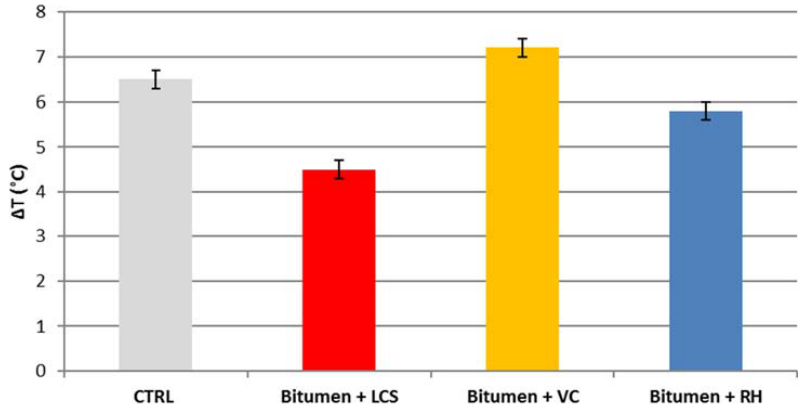
Figure 4. Comparison of Δ T = T TR (aged) − T TR (unaged) for the series of investigated samples.